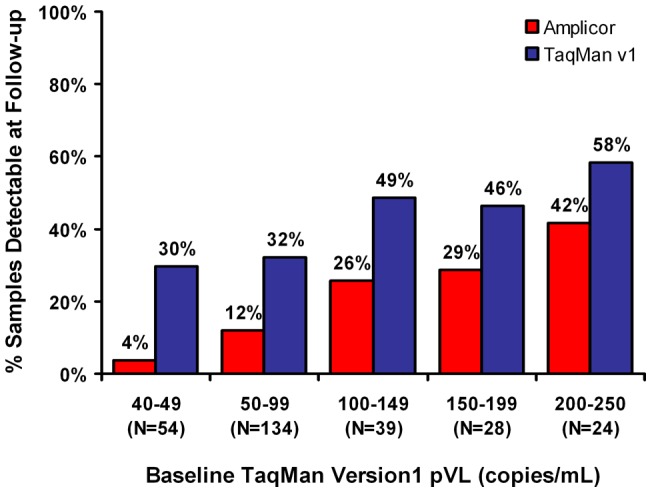
Low-level viremia by TaqMan v1 does not predict short-term virological failure.A subset of patients (N = 279) with low-level viremia (40–250 copies/mL) by TaqMan v1 were followed longitudinally for a median of 3.2 months (IQR: 2.0–4.2 months). Patients initiated HAART at least 6 months prior, and treatment regimens remained unchanged over the course of follow-up. Samples from patients' latest follow-up visit were re-tested with the TaqMan v1 and Amplicor v1.5 assays. Overall 17% of patients had a detectable viral load by Amplicor v1.5 at their latest follow-up visit, while 38% were detectable by TaqMan v1. When patients were grouped according to their baseline TaqMan v1 pVL into 50 copies/mL strata we observed a stepwise increase in the proportion of patients with detectable pVL at their latest follow-up visit by both Amplicor v1.5 (red bars) and TaqMan v1 (blue bars). Consistent with previous results, more patients had detectable pVL by TaqMan v1 than by Amplicor v1.5 at follow-up in all strata.